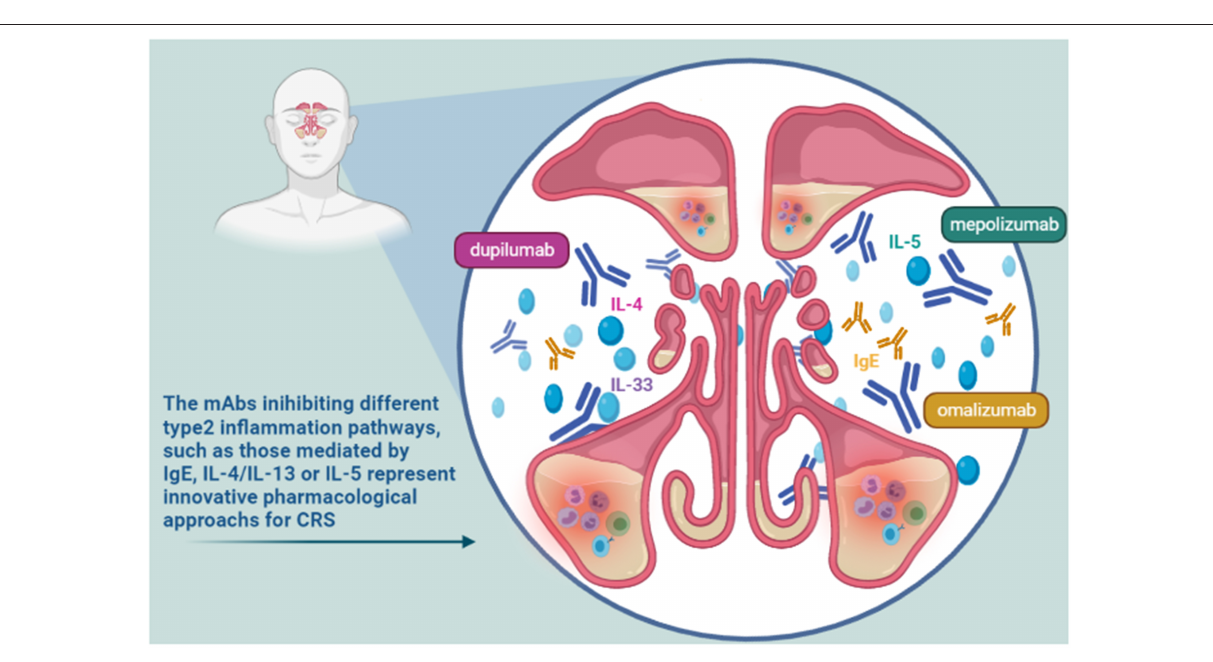
Frontiers in Allergy |